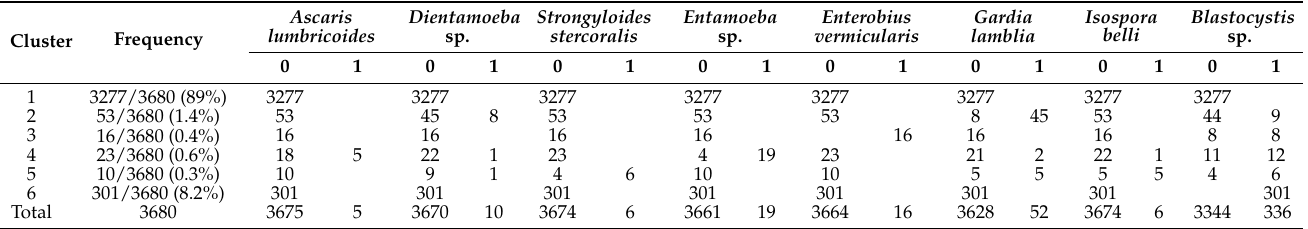
Table 4. Characteristics of individuals included in the 6 clusters obtained in the study. Absence or presence of a particular pathogen was recorded as 0 and 1, respectively.